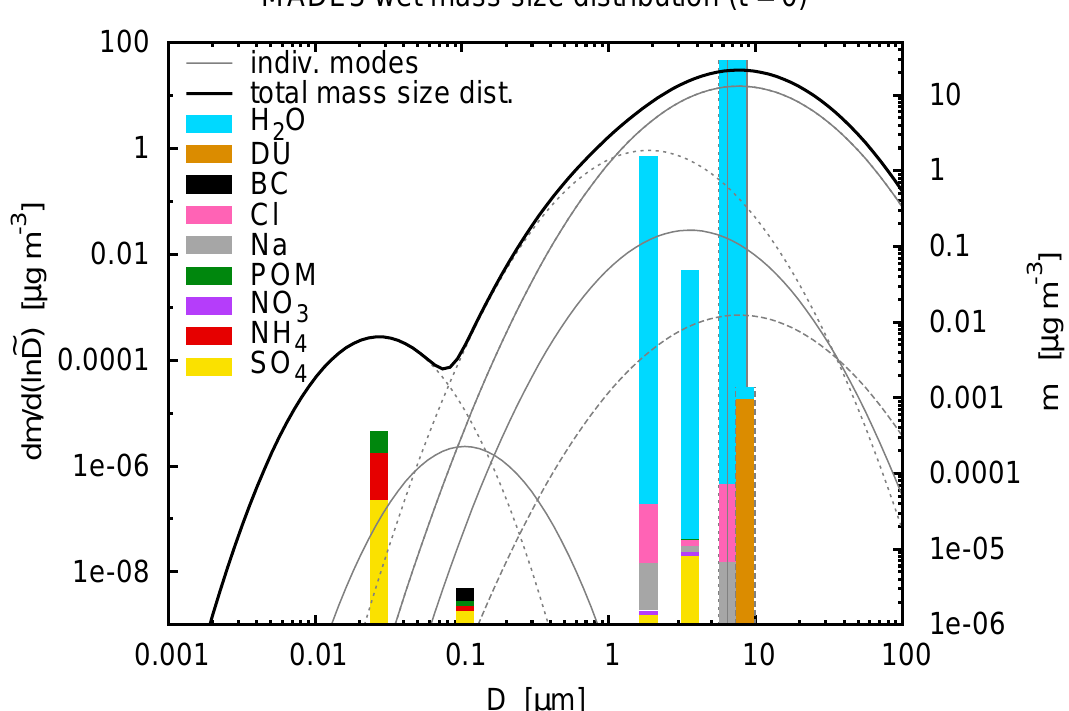
Figure 2. Initial aerosol mass size distribution and composition as represented in MADE3. The thick black line represents the mass size distribution calculated as the sum of the modes shown in grey (left vertical axis; dotted lines for soluble modes, solid lines for mixed modes, dashed lines for insoluble modes). Insoluble Aitken and accumulation mode mass concentrations are initially so small that these modes do not appear in the figure, and the curves for the soluble and mixed coarse modes lie on top of each other. The coloured bars show the contributions of the individual species (POM = particulate organic matter, BC = black carbon, DU = mineral dust) to the mass concentration (right vertical axis) of the respective mode (from left to right: soluble Aitken, mixed Aitken, soluble accumulation, mixed accumulation, soluble coarse, mixed coarse, insoluble coarse). Note that while the right vertical axis is logarithmic, the species fractions in the bars add up linearly to the total mass concentrations (i.e. the axis only applies to the total mass concentration in each mode, but not to the individual contributions). Note further that the three coarse mode bars were artificially spread out along the diameter axis and grey borders corresponding to the line styles of the respective modes were added for